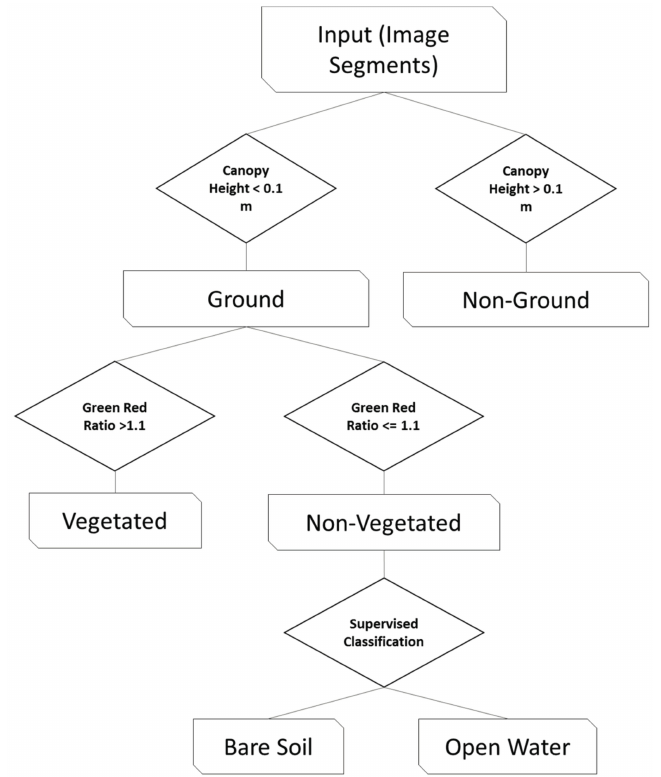
Figure 3. Object-based, decision-tree classification scheme to extract open